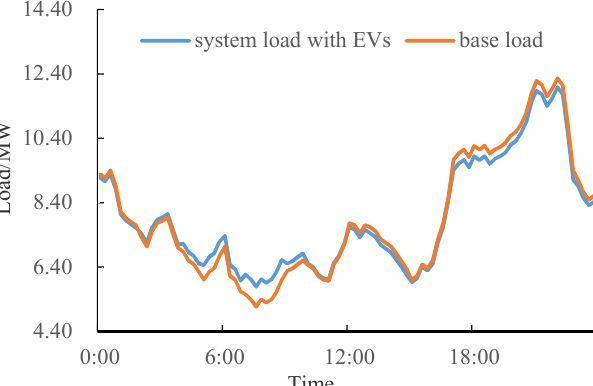
Figure 7. Comparison of load profile between base loads and loads with electric vehicles (EVs) taken into account